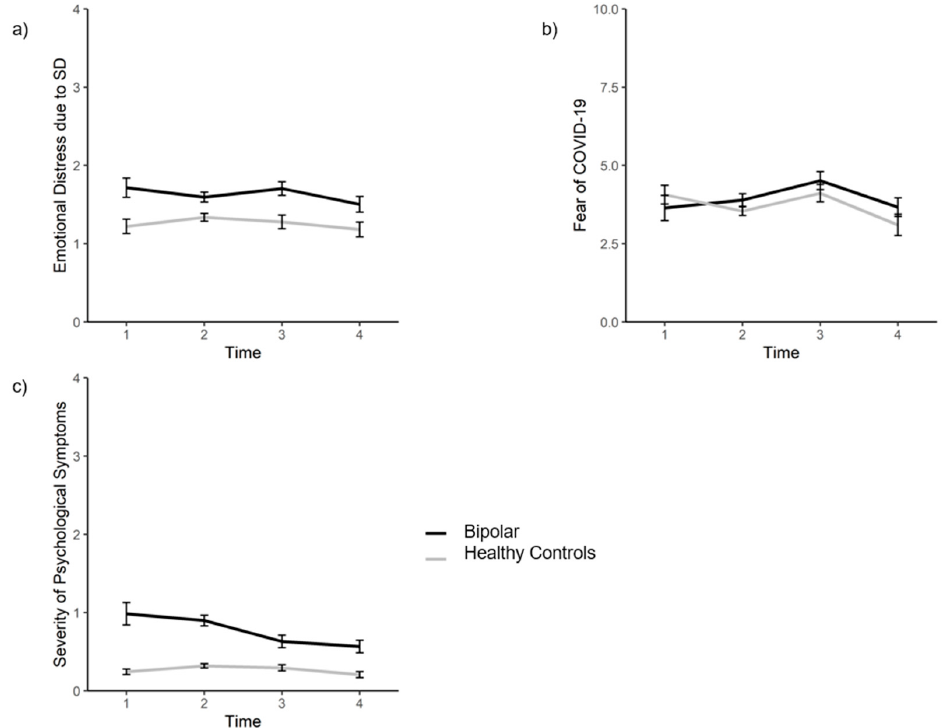
Figure 2. Emotional distress due to social distancing, fear of COVID-19, and severity of psychological symptoms scores across four measurement times in individuals with bipolar disorder (BD) and healthy controls (HC). Note. SD = Social Distancing. ( a ) Significant main effect BD, no significant main effect of time, no significant interaction between BD and time. ( b ) Significant main effect of time, but no significant main effect of BD or interaction between BD and time. ( c ) Significant main effects of BD and time, significant interaction effect of BD and time. Error bars indicate standard